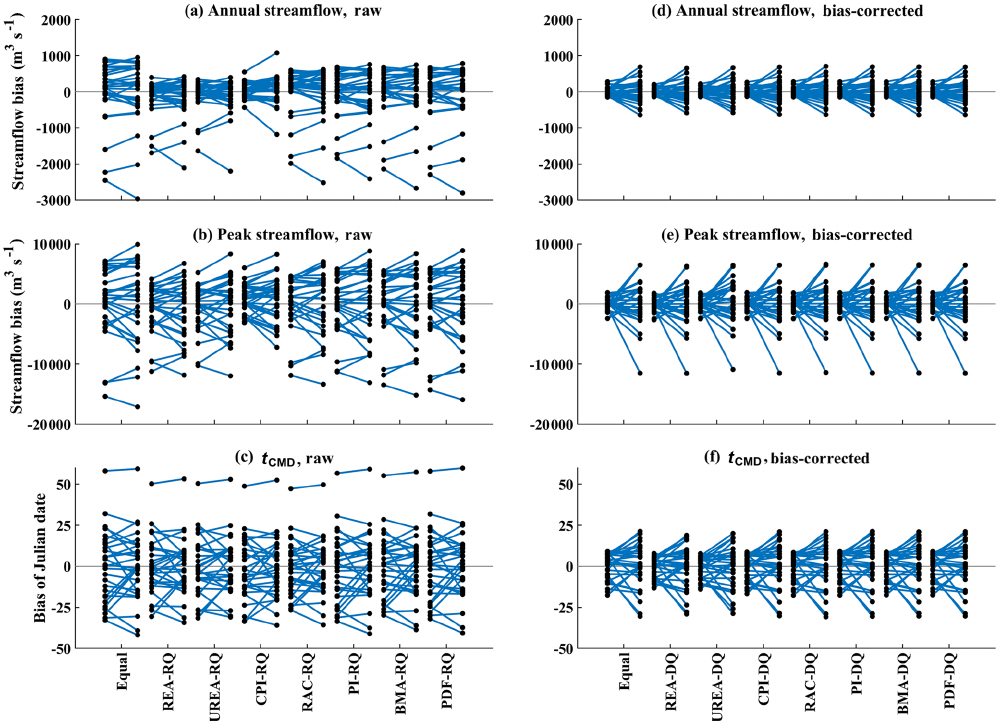
Figure 8. Bias in mean annual streamflow, mean peak streamflow, and mean center of timing of annual flow ( t CMD ) of weighted multi-model ensemble mean in the out-of-sample testing over the Xiangjiang watershed; 29 lines of each weighting method represent the results when each of 29 climate models was regarded as the “truth” in turn, and the left and right points on each line represent the biases for the reference and future periods,